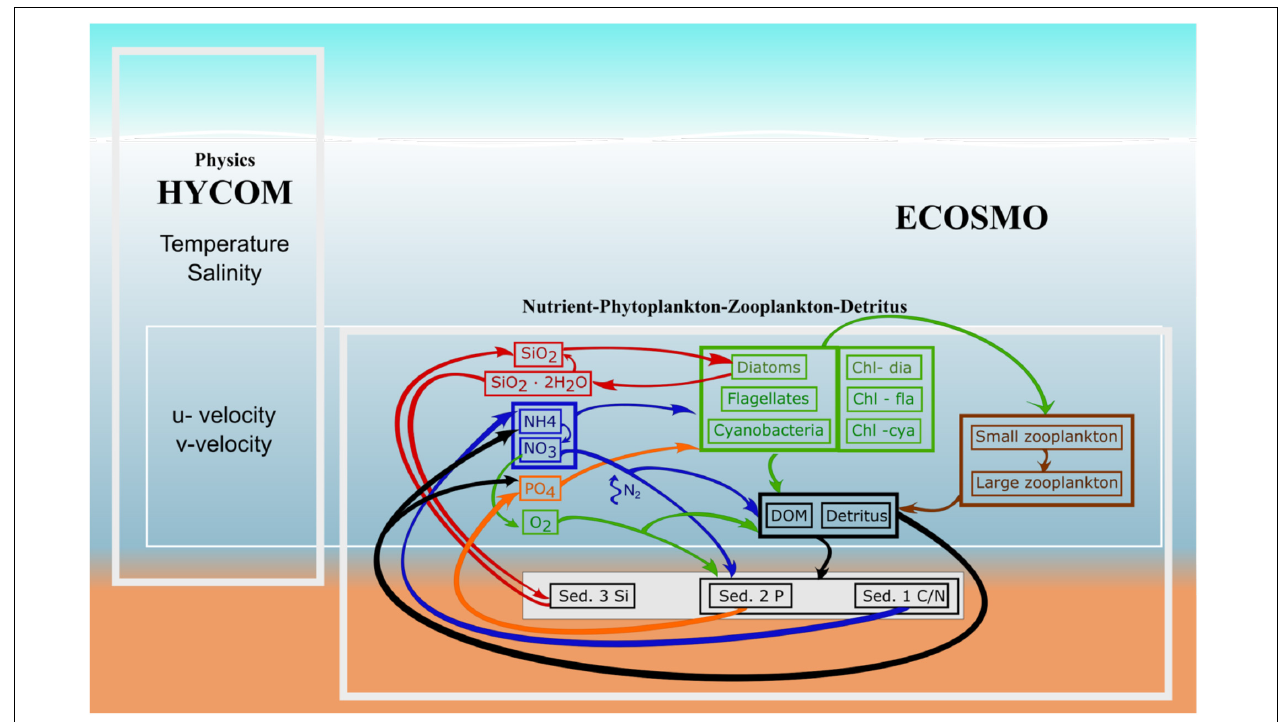
FIGURE 1 | ECOSMO flow chart, showing the model variables and their interactions with each other. The three sediments are Sed. 1, particulate organic sediment, Sed. 2, Iron bound phosphorous, and Sed. 3, the silicate sediment pool.